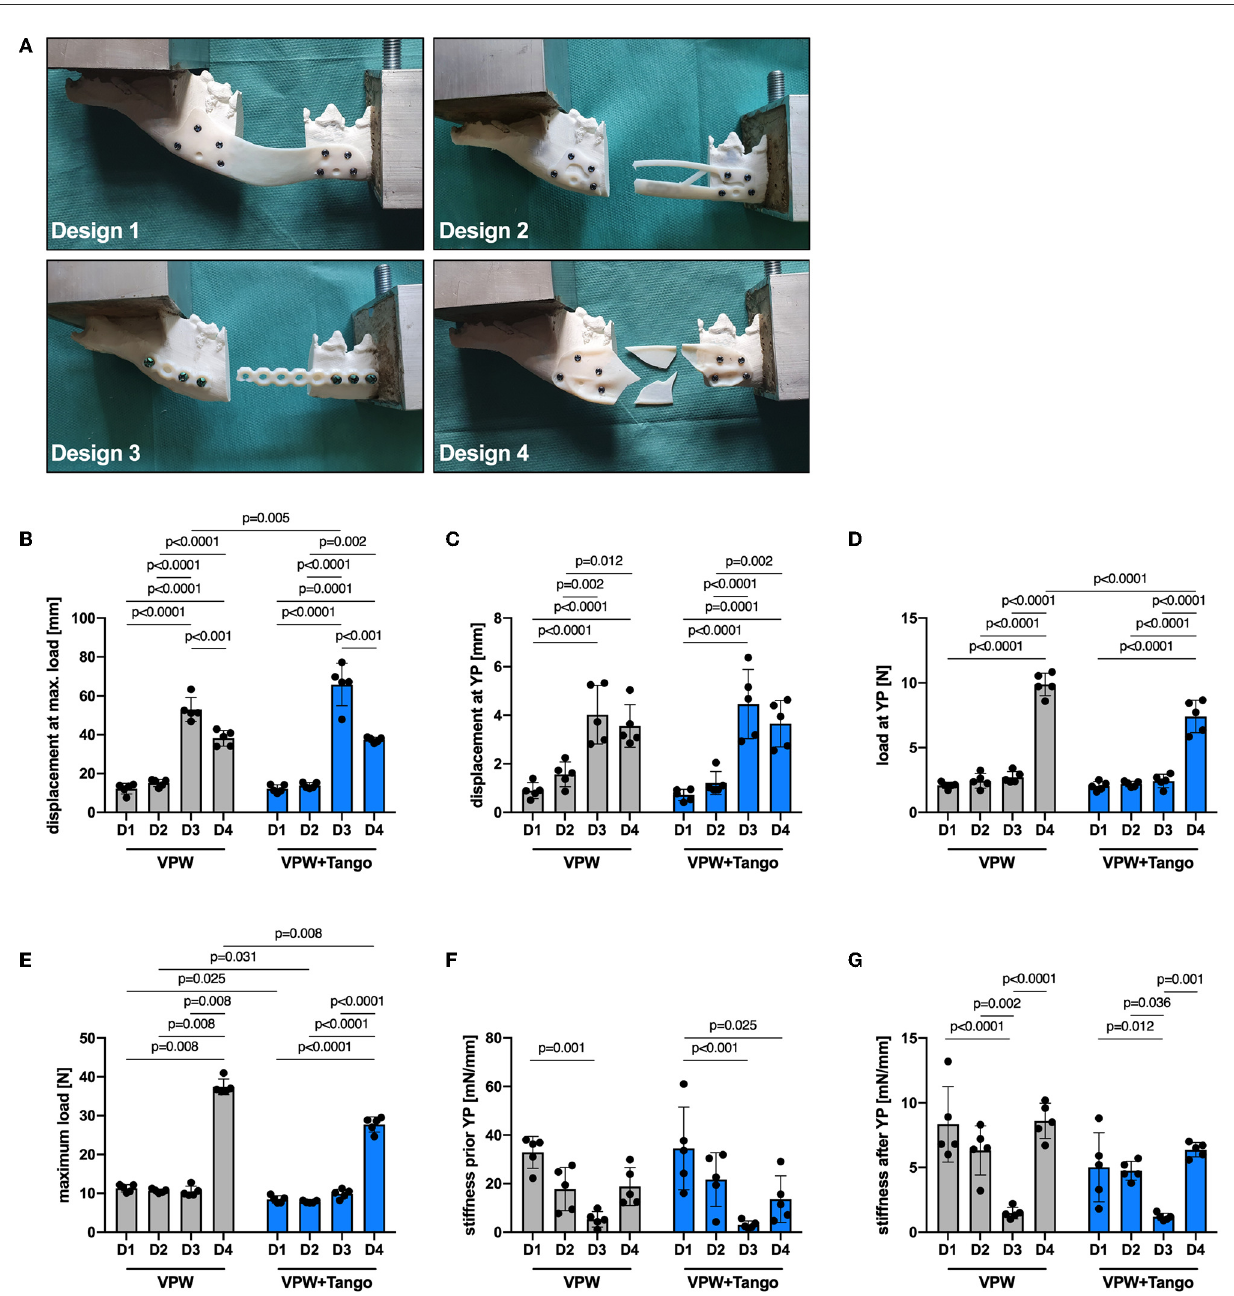
FIGURE5 Mechanical properties of plate designs D1–4 comparing rigid (VPW) and combination of rigid + rubbery (VPW + Tango) 3D printing materials. (A) Failure modes representative for different plate designs. Note bending deformation in D1 being different to breakage in other designs. (B) Displacement at maximum load, (C) displacement at yield point (YP), and (D) force load at YP; ordinary two-way ANOVA, Tukey’s multiple comparisons. (E) Maximum force load at point of failure; two-tailed Mann-Whitney-U test (VPW D1–3 vs 4, VPW D4 vs VPW + T D4) and ordinary two-way ANOVA with Tukey’s multiple comparisons for all other variable combinations. (F, G) Material stiffness prior and after YP; ordinary two-way ANOVA, Tukey’s multiple comparisons. (B–G) n = 5 replicates/design and material; bars represent mean, error bars represent ±